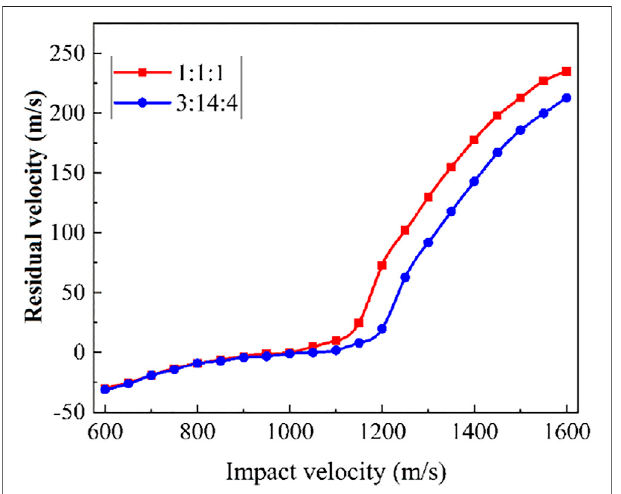
FIGURE 4 | Curve of impact and residual velocities of TC4-Al 3 Ti-Al and TC4-Al 3 Ti